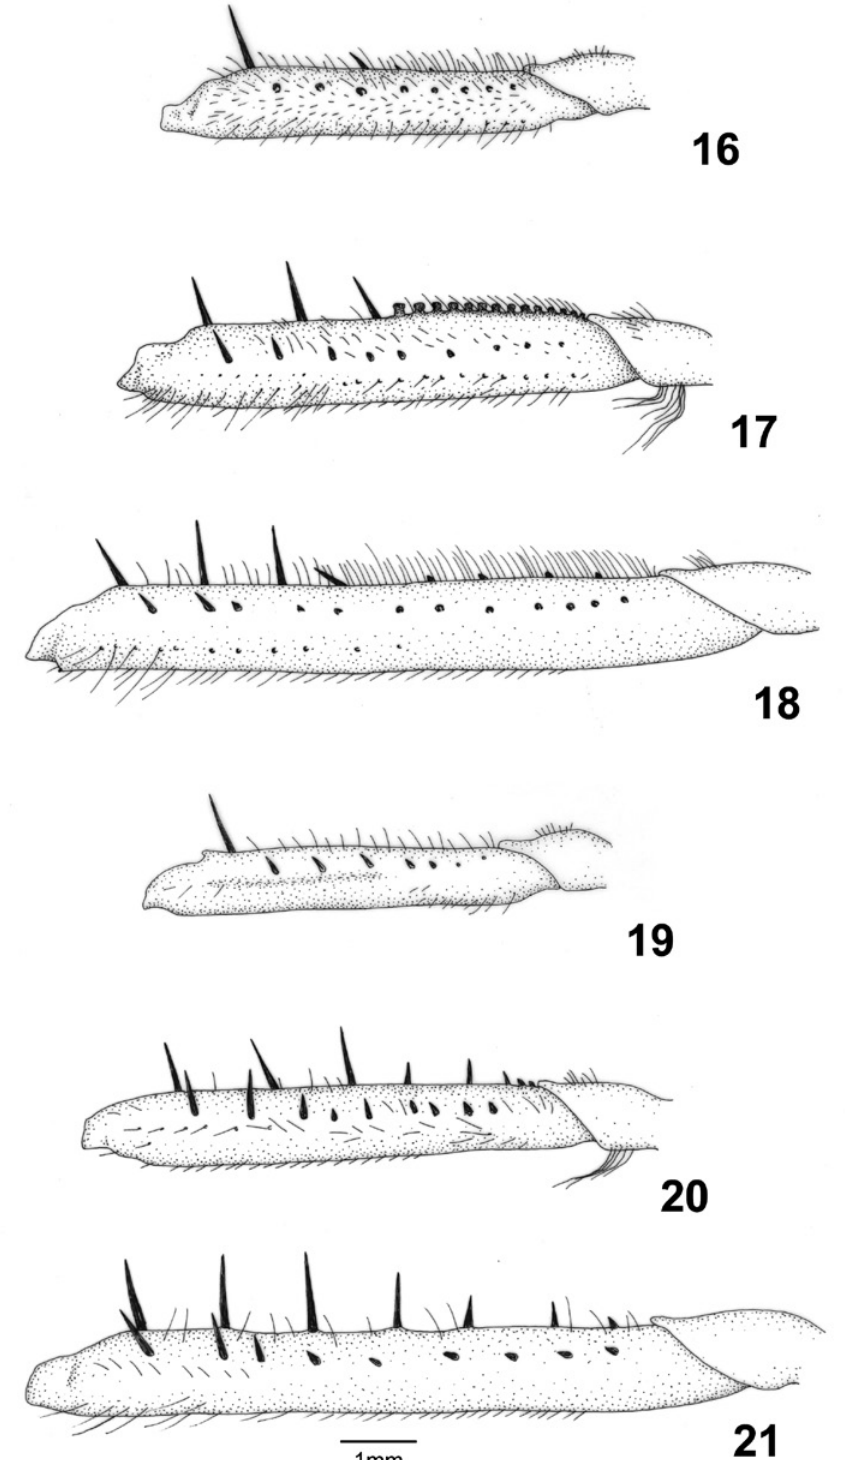
Figs. 16-21 - Carajathemis simone n. gen., n. sp. male holotype, internal view of pro (16) meso (17) and meta (18) femora. Female allotype, internal view of pro (19) , meso (20) and meta (21)